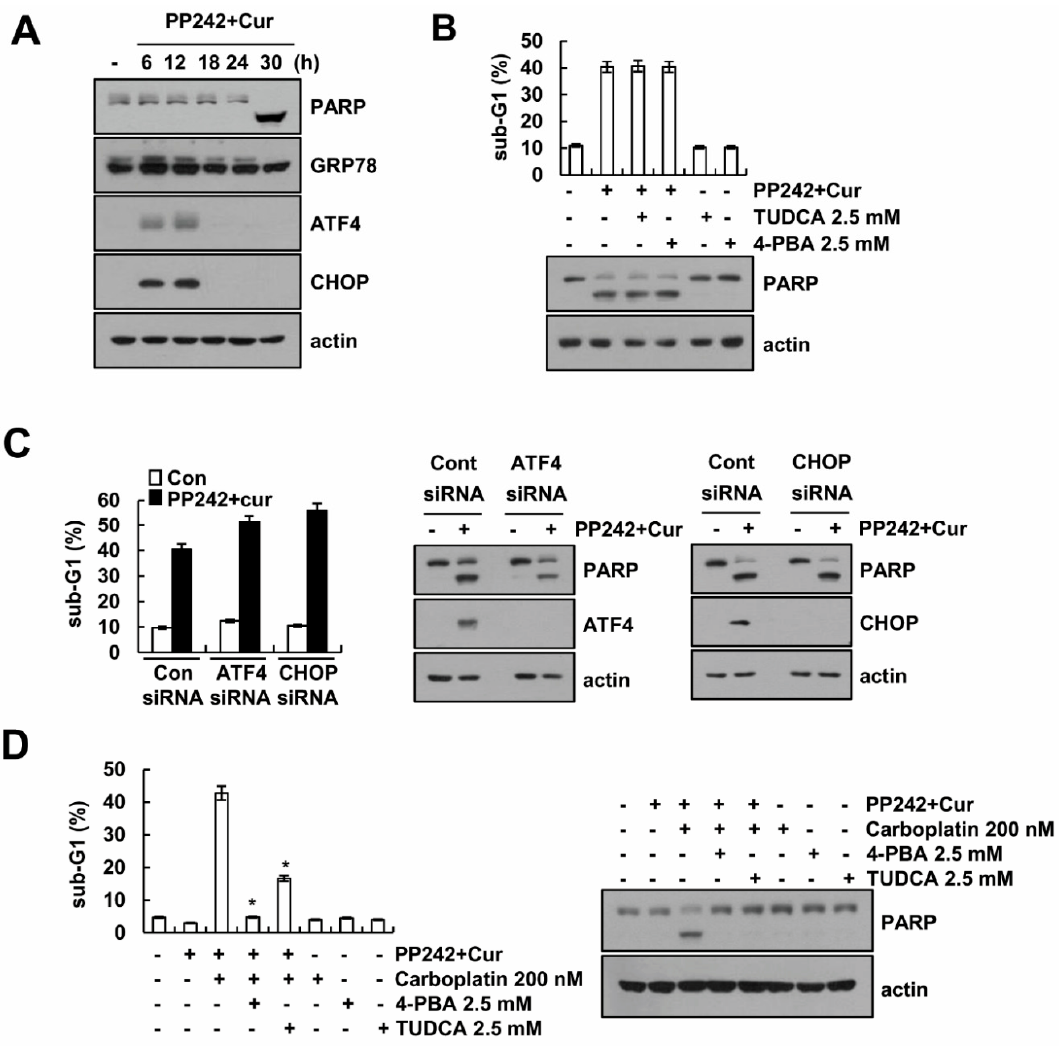
Figure 3. Induction of ER stress is not associated with PP242 plus curcumin-induced apoptosis. ( A ) Caki cells were treated with 0.5 M PP242 plus 20 M curcumin for the indicated time points. ( B ) Caki cells were pre-treated with 2.5 mM TUDCA and 2.5 mM 4-PBA for 30 min and then added with 0.5 µM PP242 plus 20 µM curcumin for 30 h. ( C ) Caki cells were transiently transfected with siRNA against control, ATF4 and CHOP. After 24 h, cells were treated with 0.5 µM PP242 plus 20 µM curcumin for 30 h. ( D ) Caki cells were pre-treated with 2.5 mM TUDCA and 2.5 mM 4-PBA for 30 min and then treated with 0.5 µM PP242 plus 20 µM curcumin in the presence or absence of carboplatin 200 nM for 24 h. Flow cytometry was used to detect the sub-G1 fraction, and western blotting was used to detect the protein levels. The values in ( B – D ) represent the mean ± SD of three independent samples. * p < 0.01 compared to PP242 plus curcumin in the presence of carboplatin.